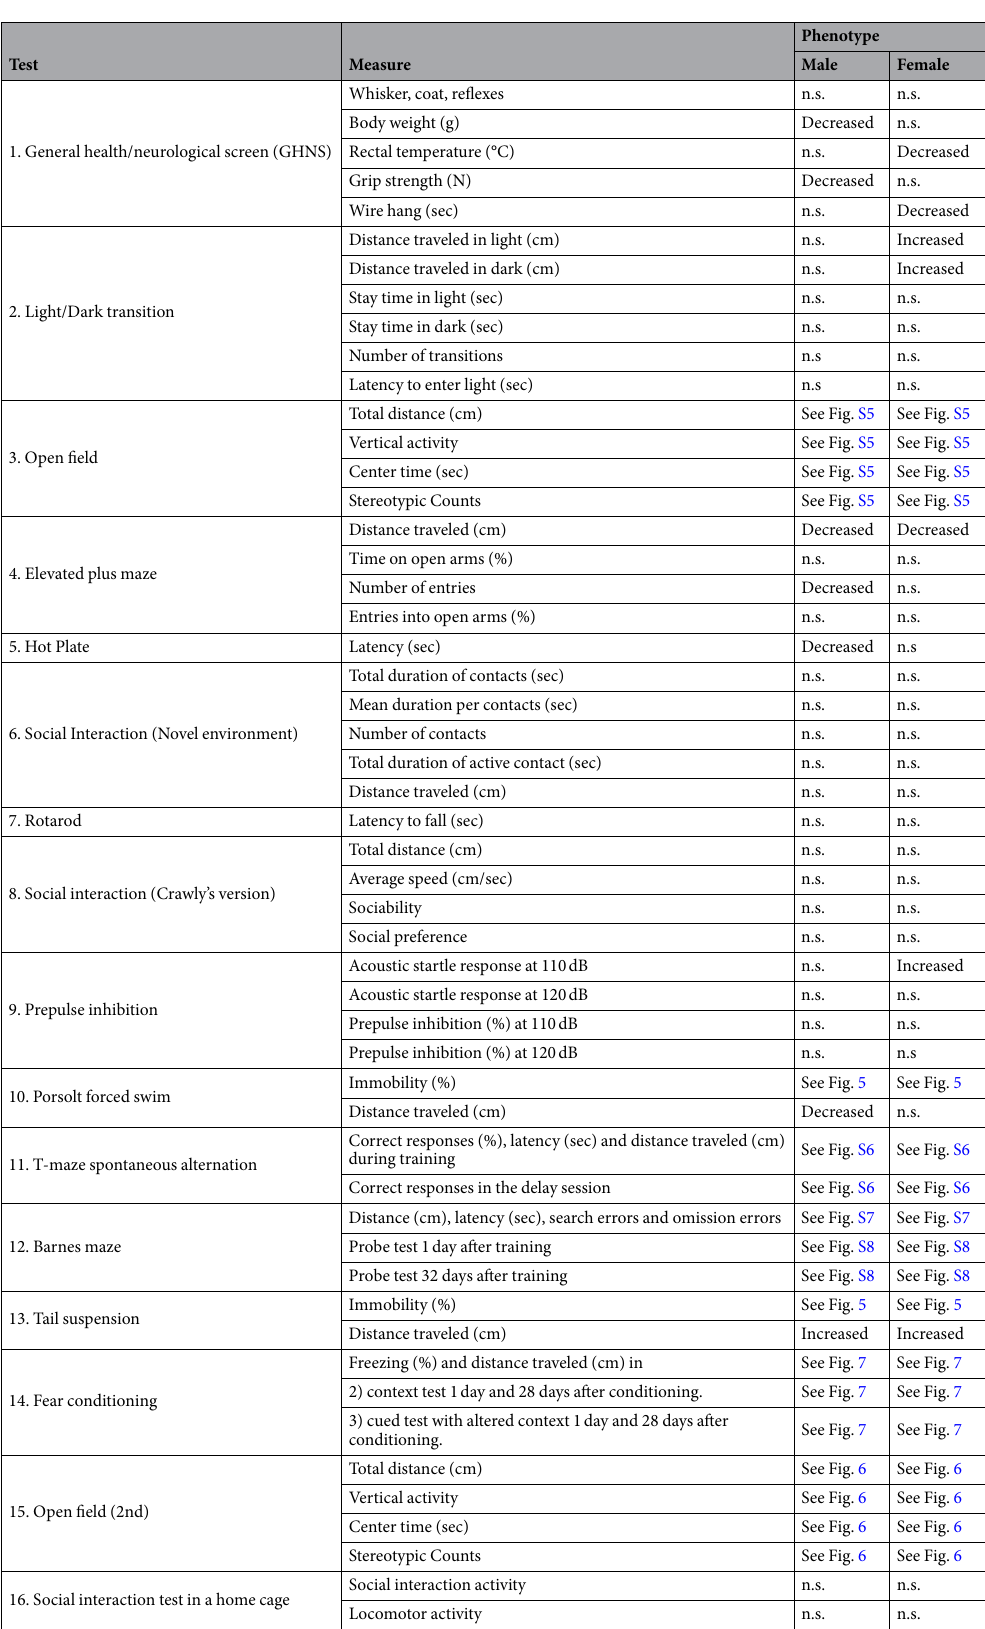
Table 1. Phenotypes of Pcdh19 hemizygous male (X − Y) and heterozygous female (X + X − ) mutants compared to wild-type counterparts. n.s., no statistical difference ( P > 0.05); Increased, statistically increased ( < 0.05); Decreased, statistically decreased ( <